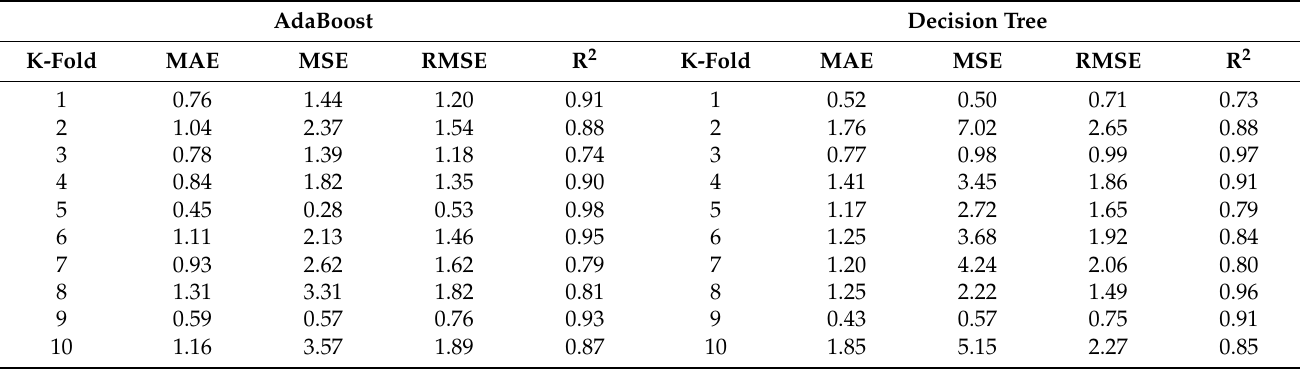
Table 4. Result of k-fold cross-validation for splitting tensile strength.